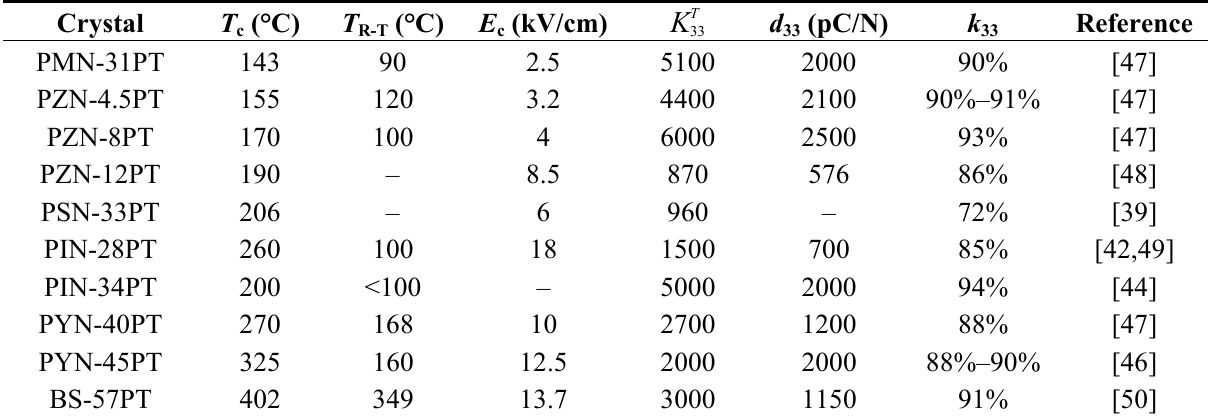
Table 2. Detailed dielectric and piezoelectric properties of relaxor-PT single crystals.